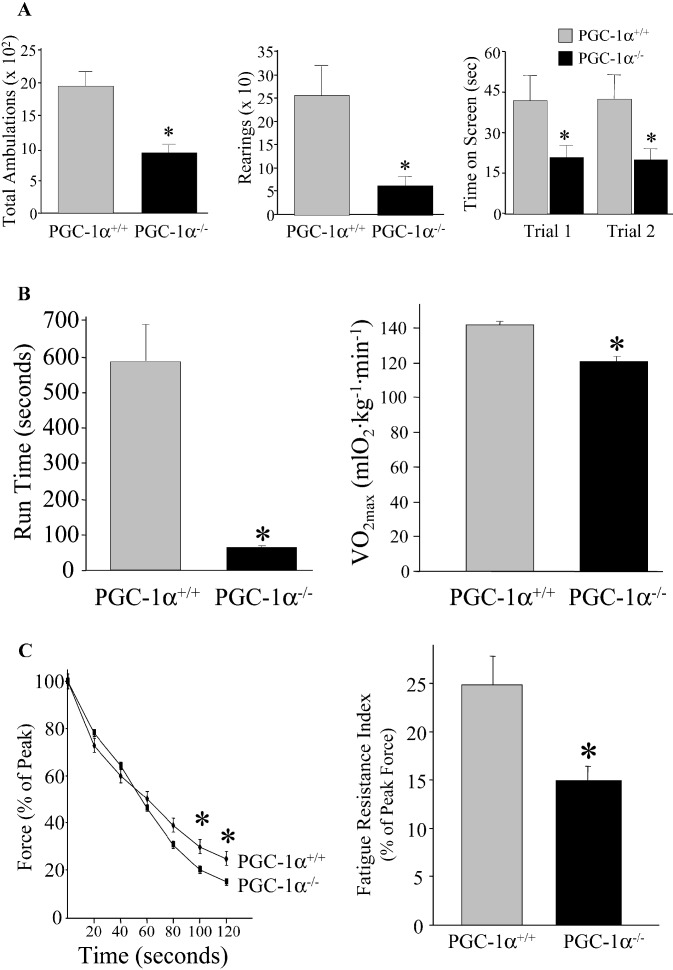
PGC-1α−/− Mice Exhibit an Abnormal Skeletal Muscle Functional Phenotype(A) Measures of general activity and muscle strength. General activity levels were measured in 3.5-mo-old male PGC-1α+/+ (n = 8) and PGC-1α−/− (n = 11) mice using a photobeam system as described in Materials and Methods. Total ambulations (left graph), and rearings (center graph) provide a general measure of locomotor activity. Time spent on an inverted screen (right graph) represents a general measure of extremity muscle strength. The results from two trials are shown. * p < 0.05 compared to corresponding PGC-1α+/+.(B) Exercise studies. Male 6–8-mo-old PGC-1α−/− and PGC-1α+/+ mice were subjected to a run-to-exhaustion protocol on a motorized treadmill (left graph) as described in Materials and Methods. * p < 0.001 compared to corresponding PGC-1α+/+ values. VO2max measurements were determined for 2-mo-old male mice for each genotype using a motorized treadmill at an elevation of 150 m and indirect calorimetry set-up (right graph) as described in Materials and Methods. * p < 0.05 compared to corresponding PGC-1α+/+ values.(C) Time course of fatigue following repeated stimulation of soleus muscle is shown for 4-mo-old male PGC-1α−/− (n = 5) and PGC-1α+/+ (n = 5) mice (left graph). The mean percent force remaining at 2 min (Fatigue Resistance Index) is shown (right graph). * p < 0.05 compared to corresponding PGC-1α+/+ values.